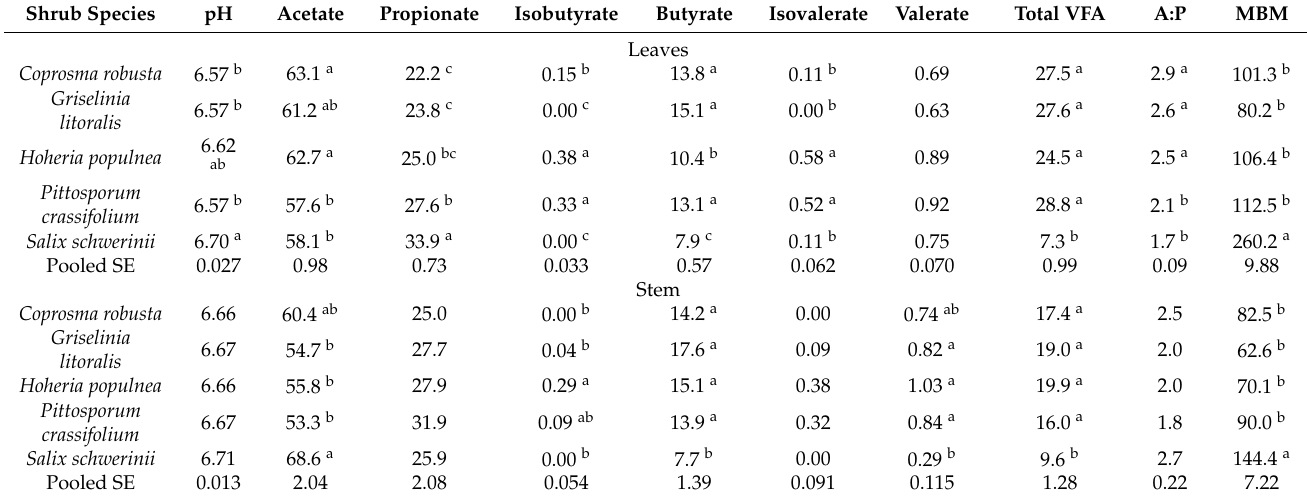
VFA, A:P and MBM with different superscripts in a column for the sample type are different at p < 0.05. Sample VFA value of 0.00 indicates the VFA was undetectable.